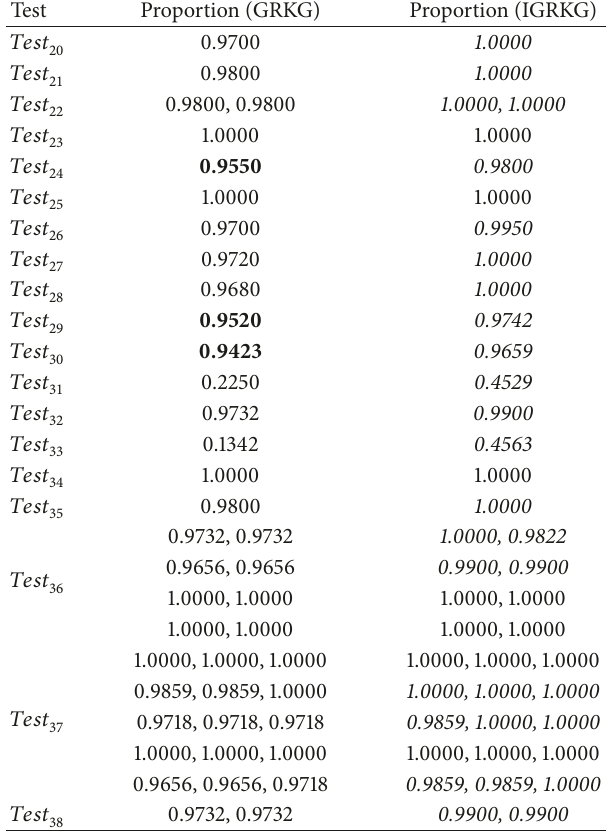
Table 13: Results obtained using NIST suite ( 𝑇𝑒𝑠𝑡 20 : frequency, 𝑇𝑒𝑠𝑡 𝑇𝑒𝑠𝑡 𝑇𝑒𝑠𝑡 21 : block frequency, 22 : cumulative sums, 23 : runs, 𝑇𝑒𝑠𝑡 𝑇𝑒𝑠𝑡 𝑇𝑒𝑠𝑡 𝑇𝑒𝑠𝑡 24 : longest run, 25 : rank, 26 : FFT, 27 : overlapping templates, 𝑇𝑒𝑠𝑡 28 : nonoverlapping templates, 𝑇𝑒𝑠𝑡 29 : binary matrix ranks 31 ∗ 31 , 𝑇𝑒𝑠𝑡 30 : binary matrix ranks 32 ∗ 32 , 𝑇𝑒𝑠𝑡 31 : binary